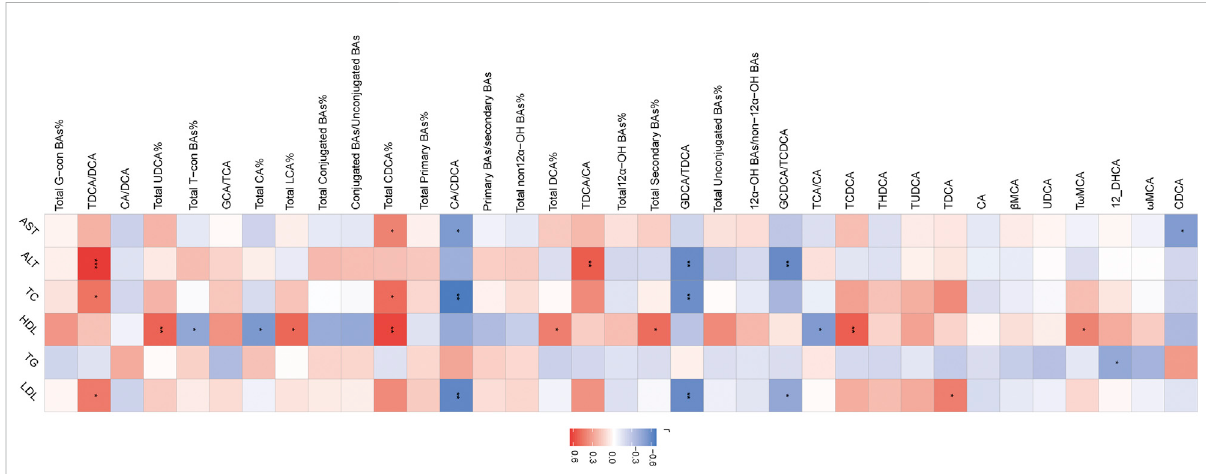
FIGURE 3 Heatmap of Spearman correlation coef fi cients between serum BAs and serum bio-chemical parameters from all samples in the three groups. n=22,sixsamplesforcontrolgroup,andeightsamplesfortheothertwogroups.Thegradientcolorsrepresentthecorrelationcoef fi cients,withred color being more positive and blue color being more negative. * p < 0.05, ** p < 0.01, and *** p < 0.001 (Spearman ’ s correlation with the post hoc correction using the Holm